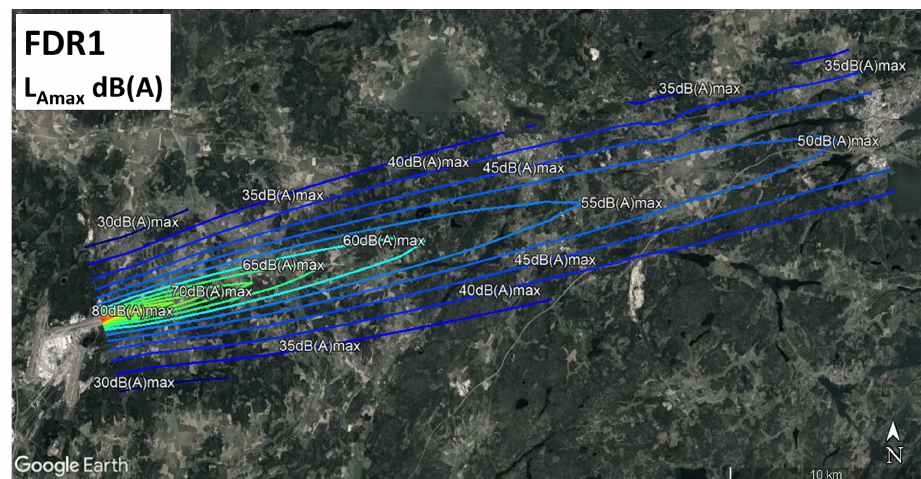
Figure 9. Noise prediction for FDR1 computed with SAFT ECAC Doc 29 implementation.